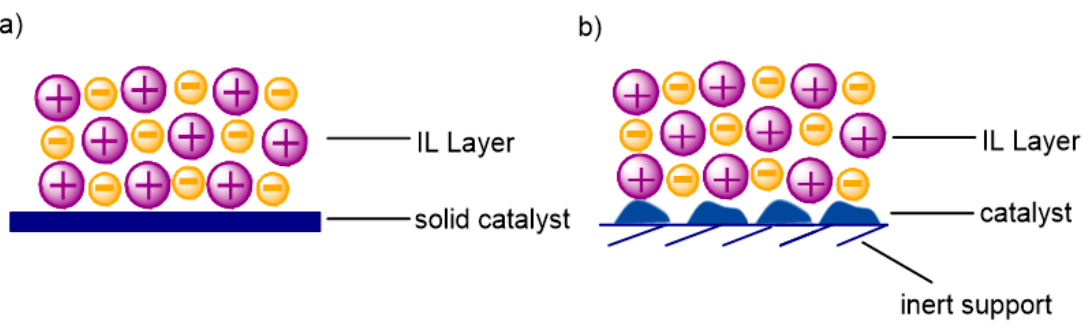
Figure 6. Two kinds of solid catalysts with ILs (SCILLs): ( a ) With catalytically active support; ( b ) with heterogeneous catalyst on an inert support.